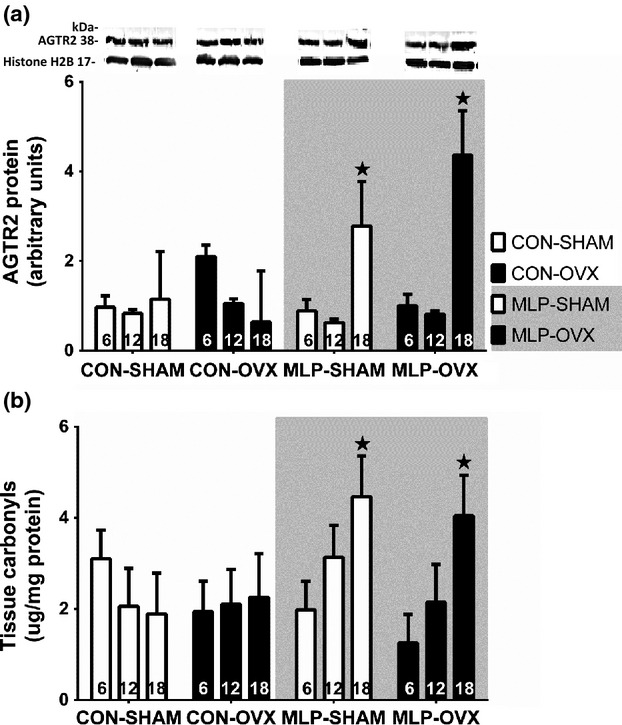
Western blot analysis and cropped images of the protein expression of angiotensin receptor type 2 (AGTR2) and the protein carbonyls concentration in the renal cortex at 6, 12, and 18 months of age. AGTR2 expression increased at 18 months of age, due to increases in MLP groups (P < 0.05*). Three-way ANOVA for AGTR2 showed a significant interaction between the diet and age, (P < 0.05*). The tissue carbonyls increased with age, due to increases in MLP groups 6 < 18, (P < 0.05*) and there was an interaction age*diet, showing an increase in tissue carbonyls at 18 month in MLP group, (P < 0.05*). White columns represent sham females (SHAM-open bars) and black columns represent ovariectomized females (OVX-closed bars). Data are presented as mean ± SEM for n = 8 per group.